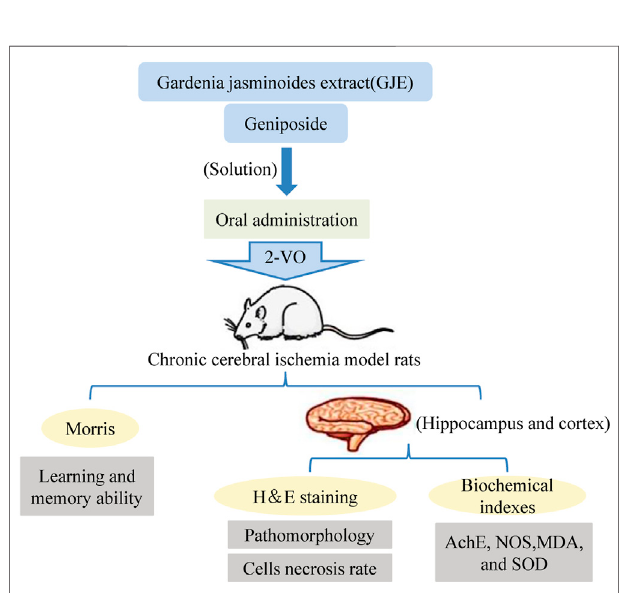
FIGURE 7 | The neuroprotective roles of Gardenia jasminoides extract (GJE) and Geniposide on a rat model with chronic cerebral ischemia (Zhang et al.,